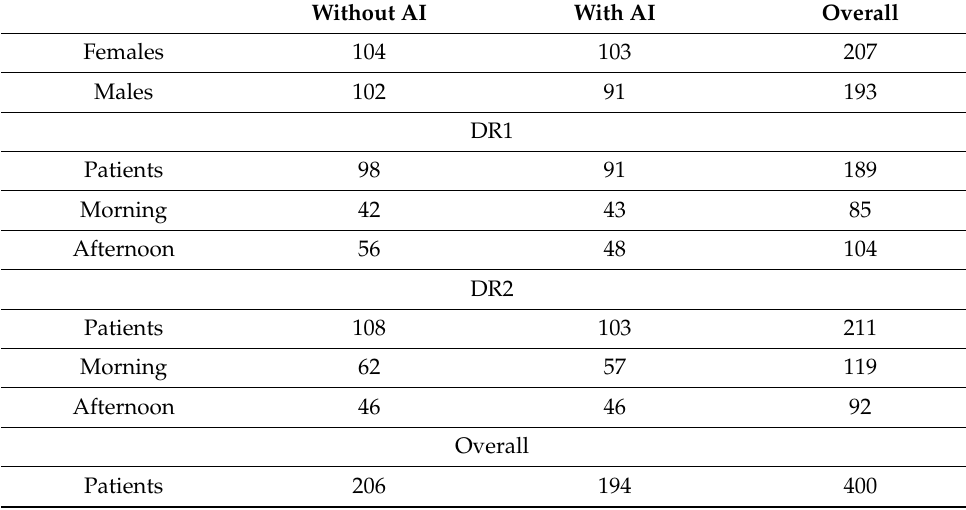
Table 1. Overall patient characteristics.